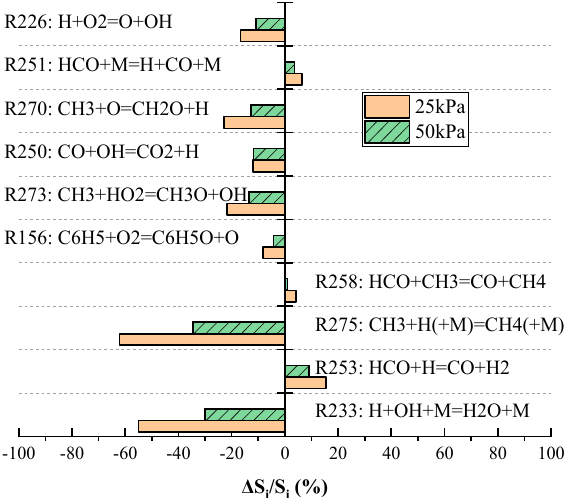
Figure 12. Variations in normalized sensitivity coefficients with pressure.